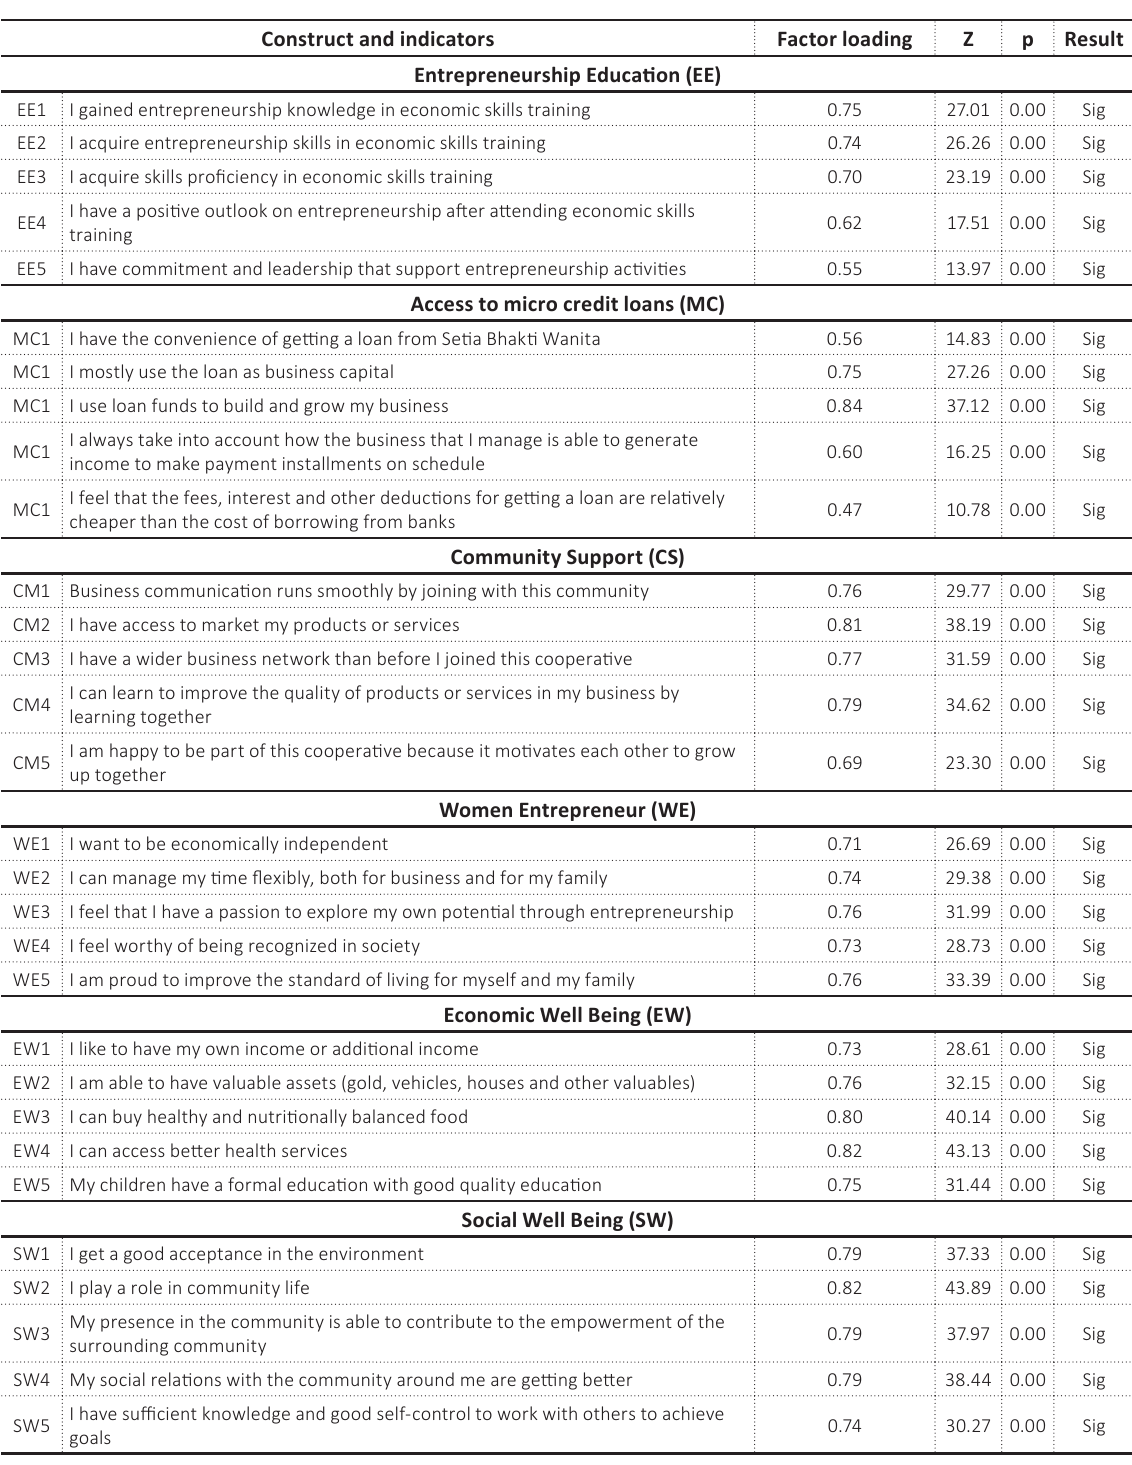
Table 1. Confirmatory factor analysis results Construct and